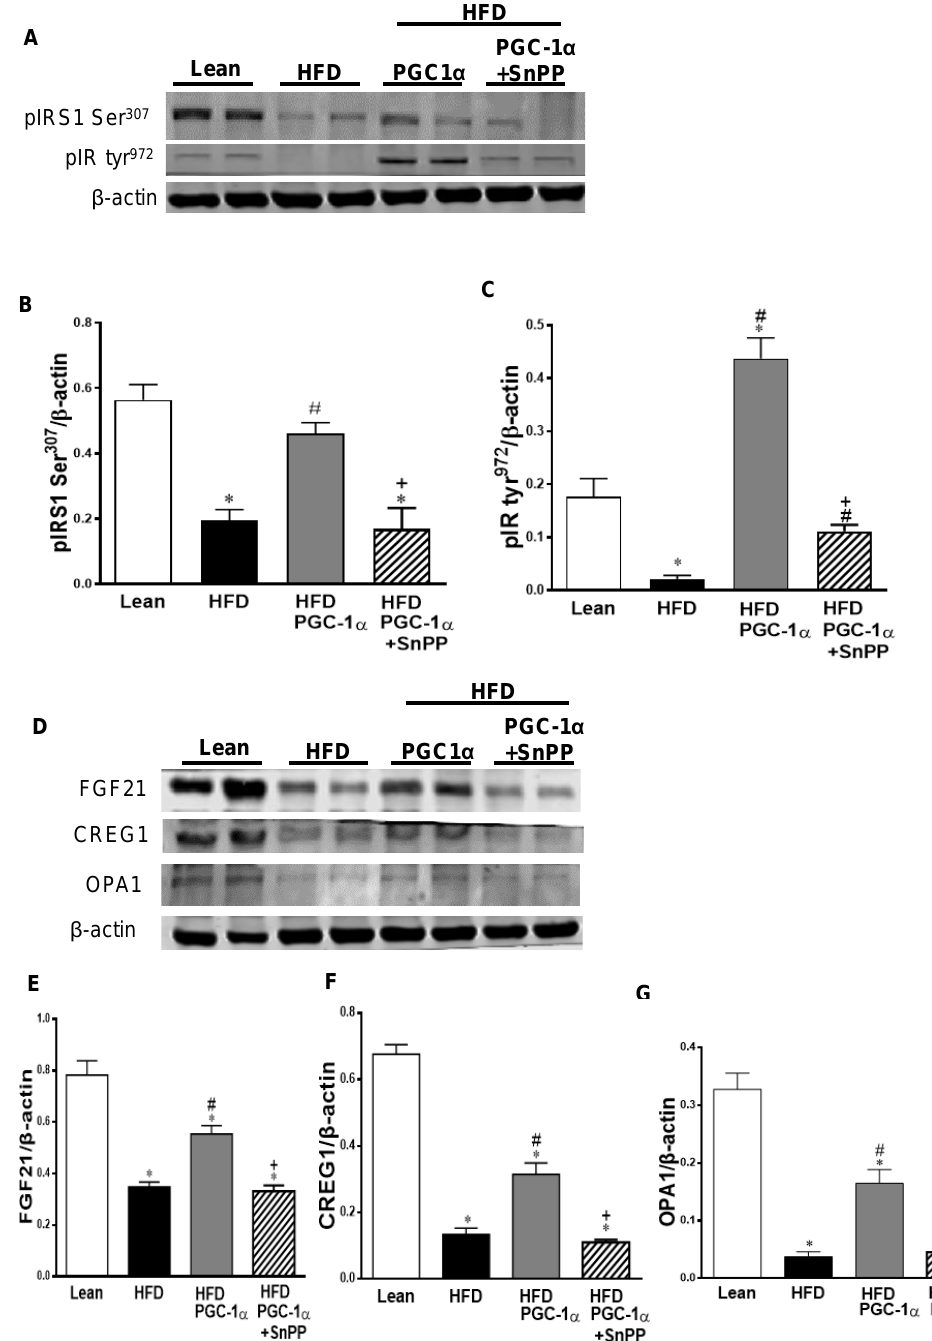
Figure 8. Effects of SnPP treatment on insulin-receptor phosphorylation and mitochondrial fission in the adipose tissue of Transgenic-adipo-PGC-1 α mice fed with high-fat diet (H.F.D.). Representa- tive Western blots of ( A ) phosphorylated insulin-receptor substrate 1 serine 307 (pIRS1 ser 307 ) and phosphorylated insulin-receptor tyrosine 972 (pIR Tyr 972 ) with the corresponding quantitation to β -actin ( B , C ). ( D ) Representative Western blots of FGF21, CREG1, and OPA1 with the corresponding quantitation to β -actin ( E – G ). Data are expressed as mean ± S.E.M. ( n = 5); * p < 0.05 versus lean; # p < 0.05 versus H.F.D.; + p < 0.05 vs. PGC-1 α